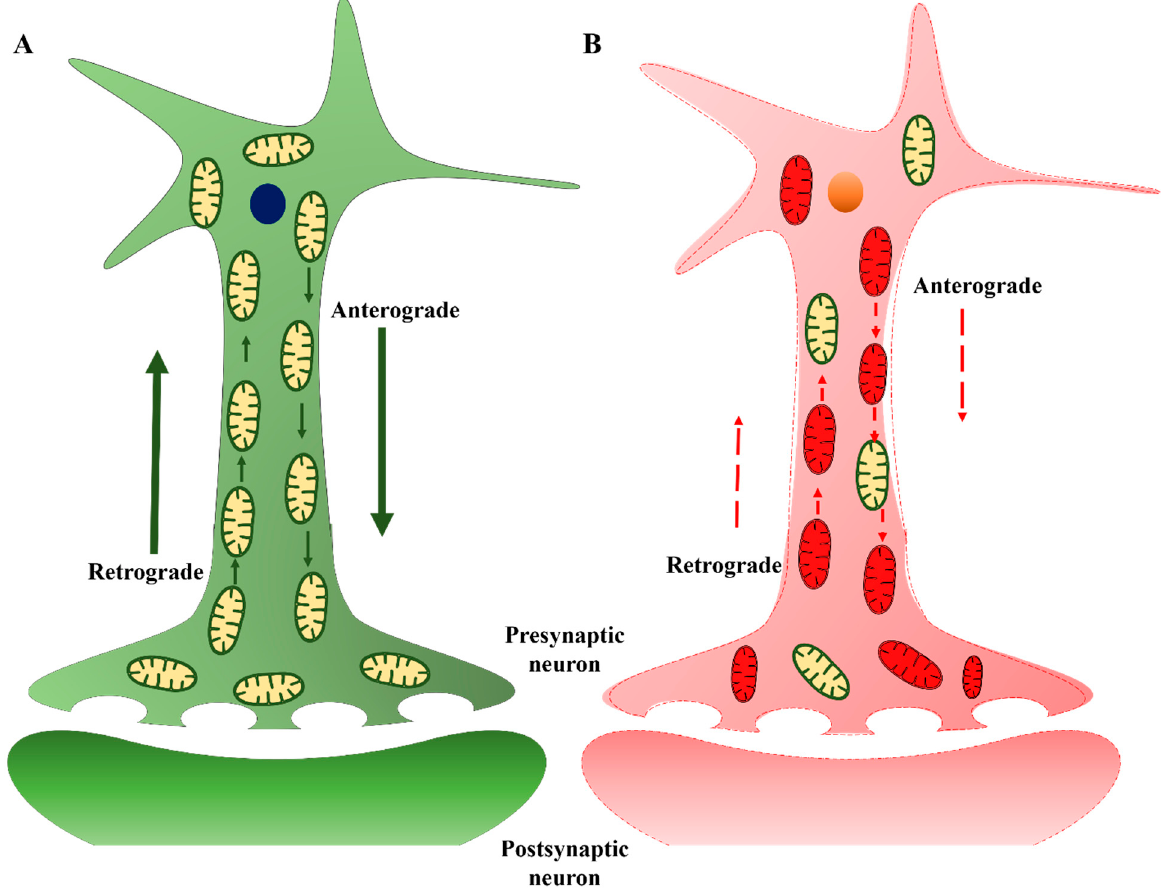
Figure 3. Neuronal mitochondrial trafficking is largely interrupted in AD. ( A ). In healthy neurons, mitochondria move from the cell body to axons, dendrites, and synapses by an anterograde mechanism, supplying ATP to nerve terminals. Mitochondria then travel back to the cell body from synapses through a retrograde mechanism. ( B ). In AD neurons, these mechanisms are disrupted primarily due to defective or functionally inactive mitochondria.